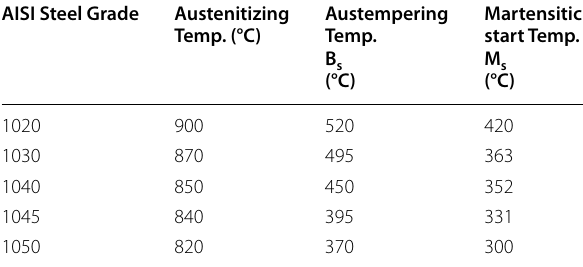
Table 2 Parameters of heat treatment processes applied to experimental plain carbon steels AISI Steel Grade